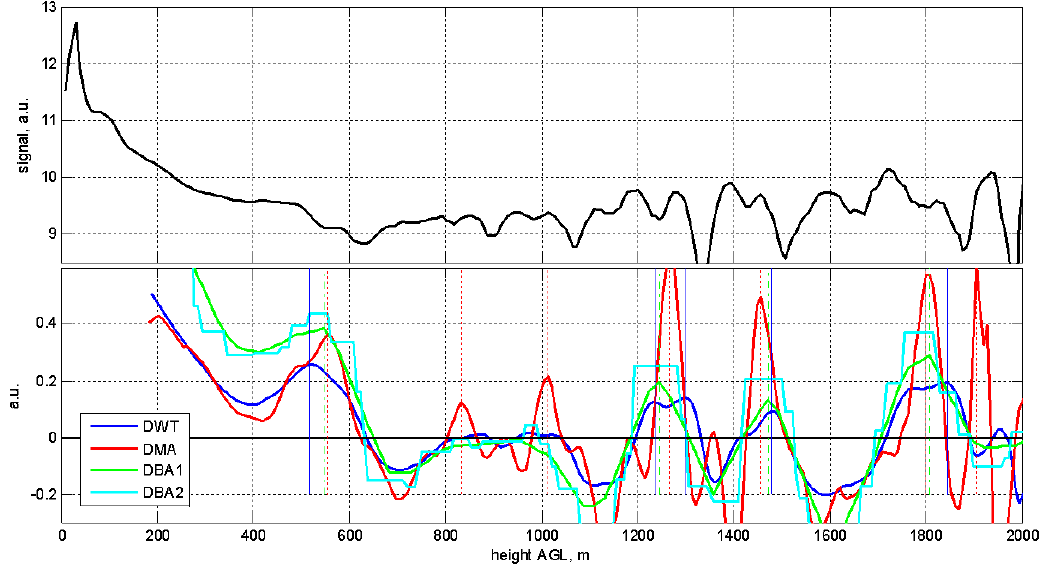
Figure 3. Upper panel: Signal (green) and smoothed signals using different window sizes. Bottom panel: The gradient of the signal as cal- culated bt DWT, Derivative on Moving Average and Derivative on Block Average. In all cases, the multi-scale approach was the same, span- ning from 9 (15) to 24 points of dilation with an increment of 3 each time. Each resulting curve is the average of the six profiles obtained at different dilation, as explained for example in de Haij et al. [2007]. The vertical lines represent the top of the aerosol layers detected when the functions in the bottom panel exceed a threshold at its maxima. The threshold in this case is set at 0.05.